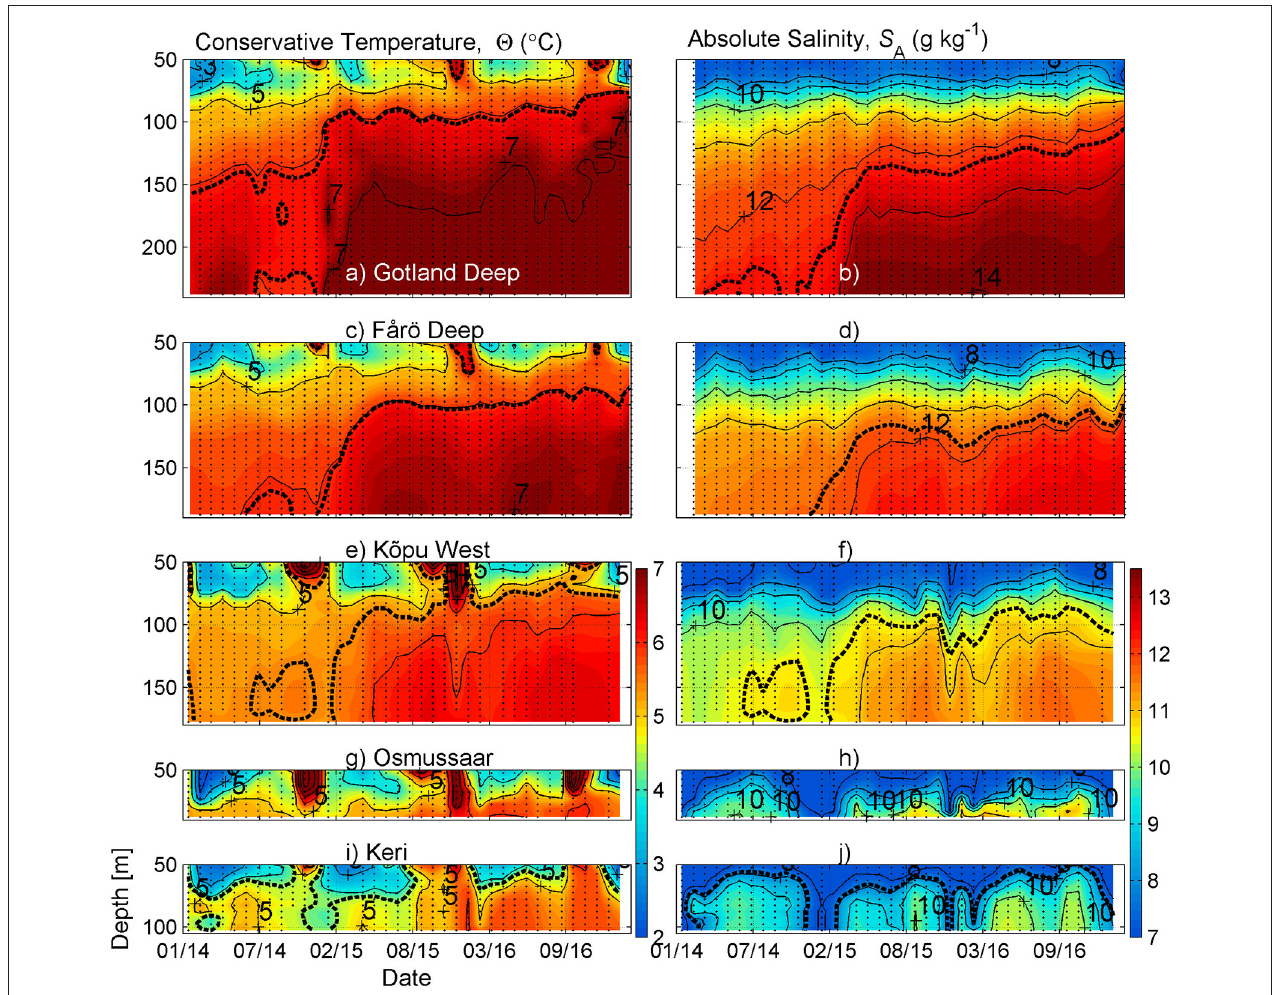
FIGURE 4 | Time-series of monthly mean temperature and salinity in the Gotland Deep (a, b) , Fårö Deep (c, d) , Kõpu West (e, f) , Osmussaar (g, h) and Keri area (i, j) from January 2014 to March 2017. Black solid isolines are shown by 1 ◦ C and 1g kg − 1 step. Black dashed lines show the near-bottom water temperature and salinity before the water of MBI in December 2014 arrived to the Gotland Deep. Vertical dashed lines represent the months with available